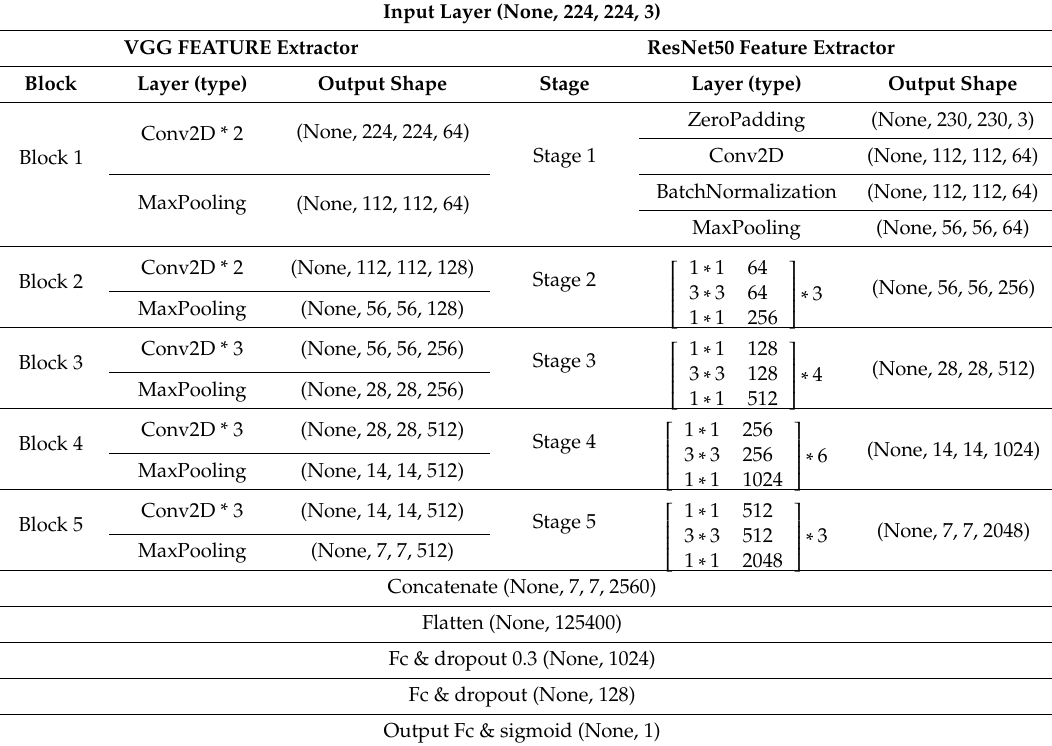
Figure 5. Fusion deep network structure. Table 1. The details of fusion deep network structure.